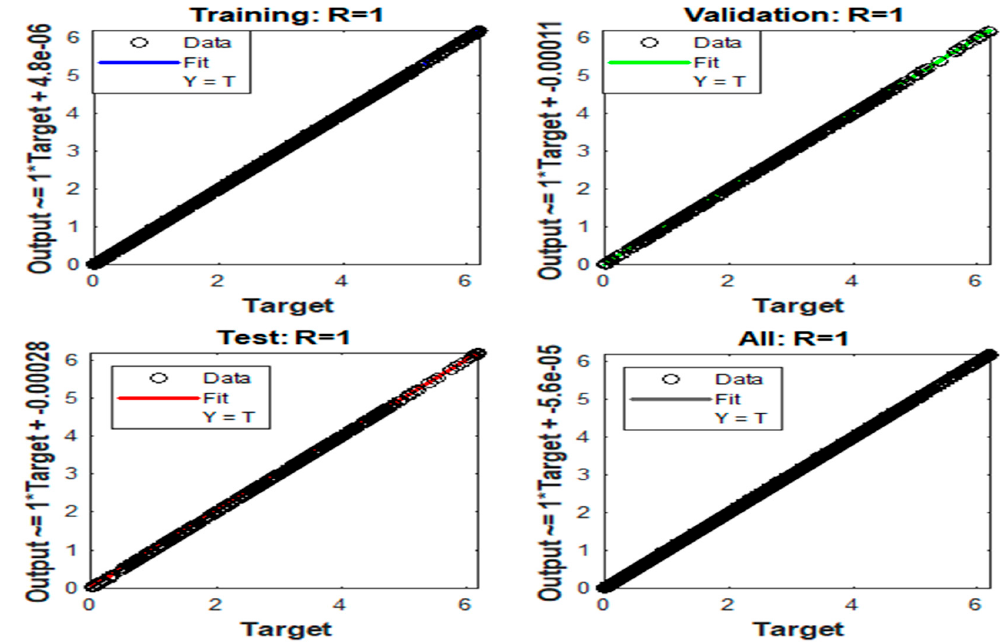
Figure 9. NARX controller showing best